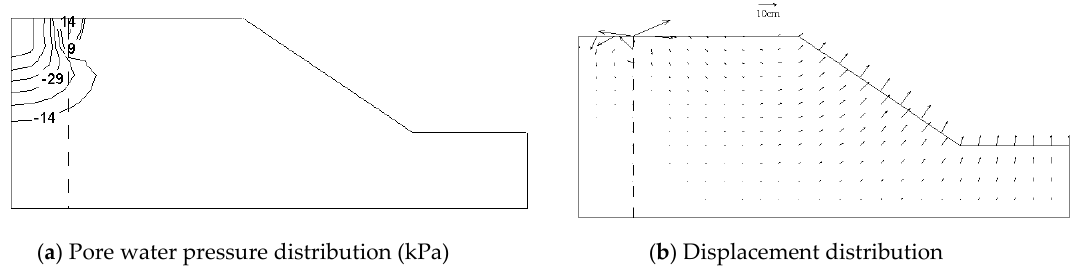
Figure 7. The distributions of pore water pressure and displacement at the end of rainfall when the crack was located 600 cm from the left edge of the soil slope.